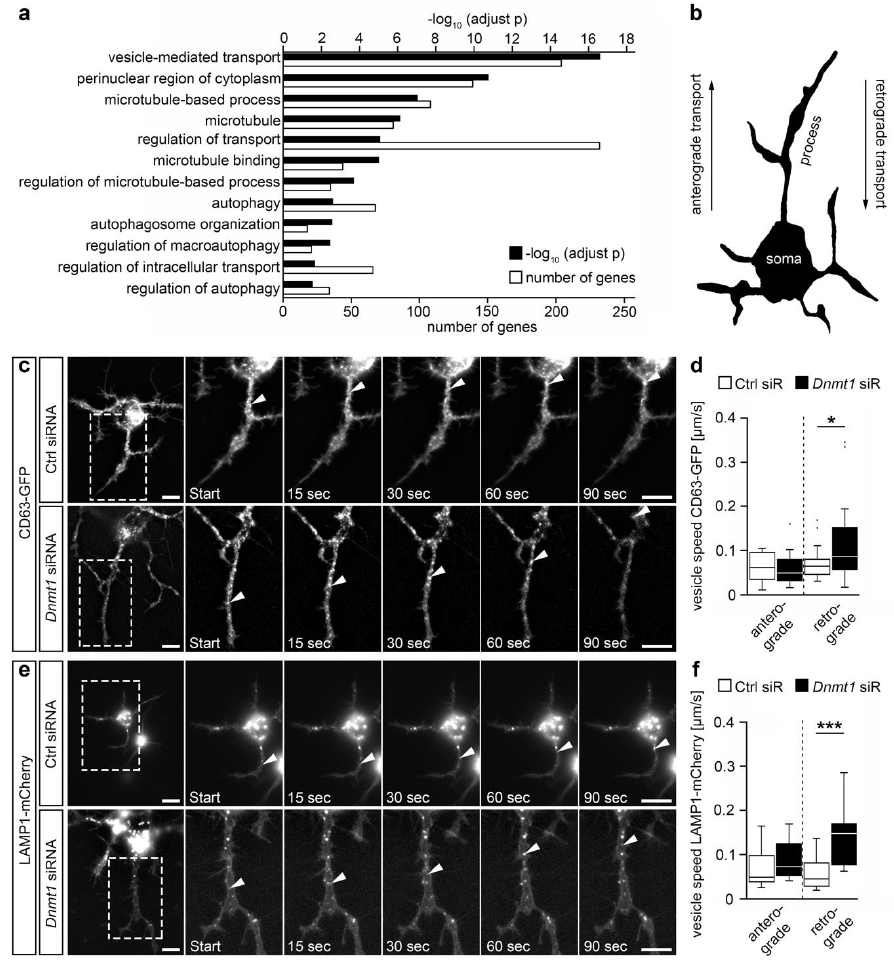
Figure 1. DNMT1 acts on retrograde vesicle transport. ( a ) GO terms found significantly enriched for genes that were up-regulated upon Dnmt1 deletion in adult Pvalb-Cre -expressing cortical